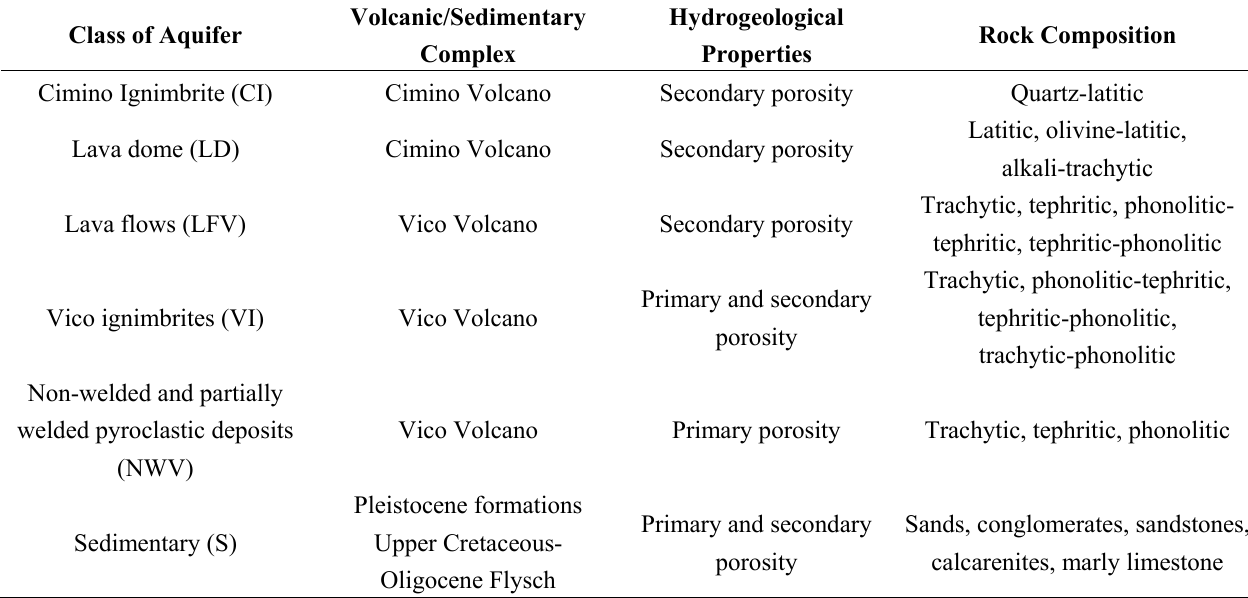
Table 1. Classes of aquifers and main